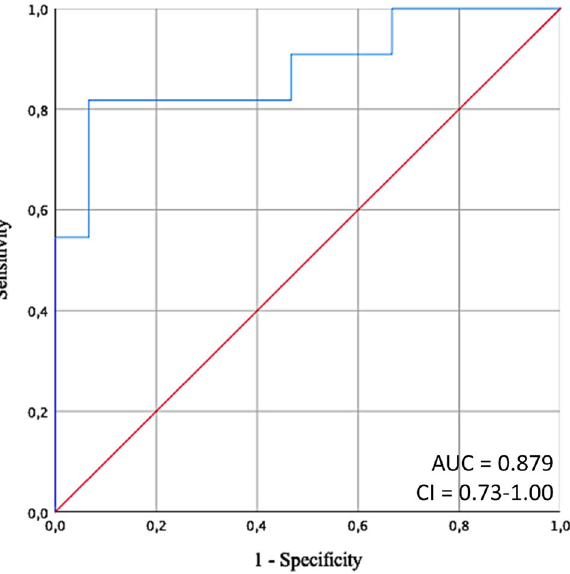
Figure 4. Receiver operating characteristic curve. Receiver operating characteristic curve to determine the ability of central pulse pressure variation to predict a ≥ 10% decrease of small intestinal microcirculation after ischemia/reperfusion. Direction of the test was set to decreasing values of pulse pressure variation. AUC = area under the curve, CI = 95% confidence